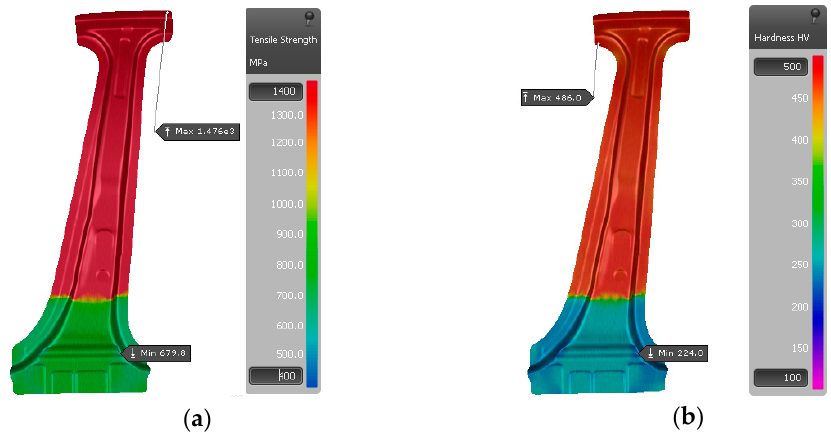
Figure 13. Distribution of ( a ) tensile strength; ( b ) Vickers hardness.